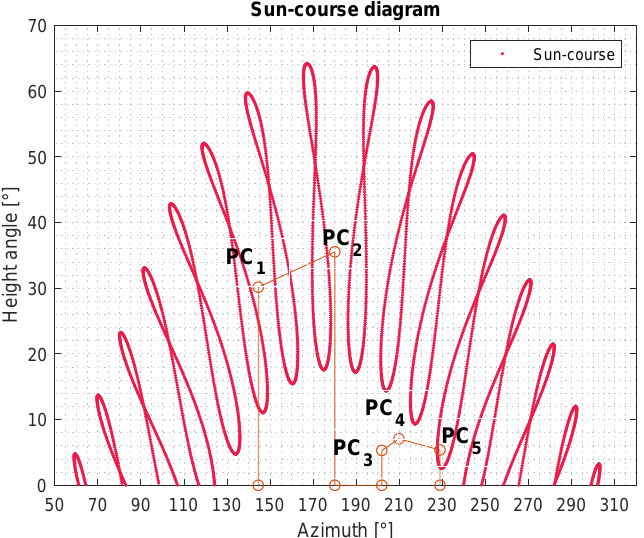
Figure 4. Solar paths and objects that cast